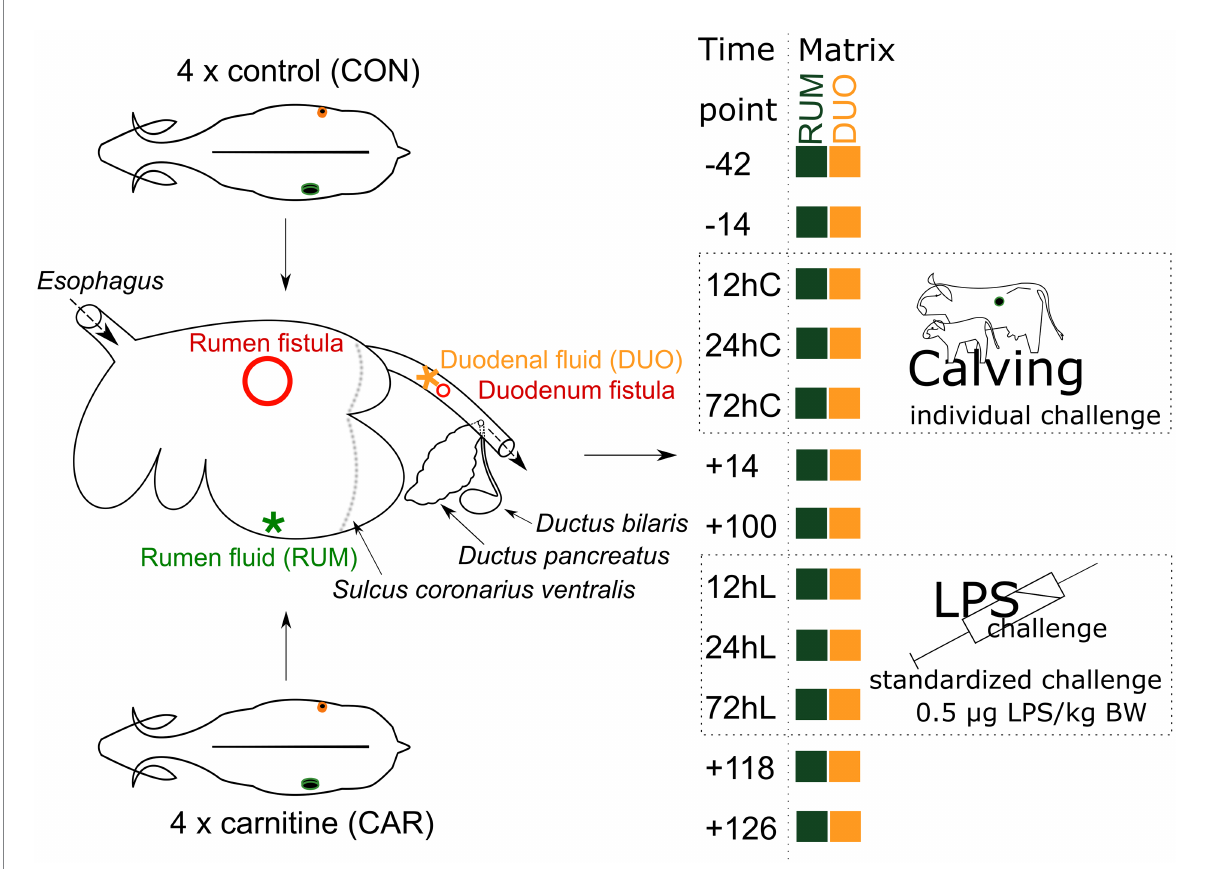
FIGURE 1 MitoCow—Trial setup. Rumen (RUM) and duodenal (DUO) fluid samples were taken from 4 control and 4 carnitine supplemented animals at 12 different time points. Stars indicate where the samples were taken from red circles indicate the place of fistulation. Time points including a “–“or “+” indicate days antepartum or postpartum and time points including “hC” or “hL” are samples taken at 12, 24, or 72 h after calving or LPS challenge,